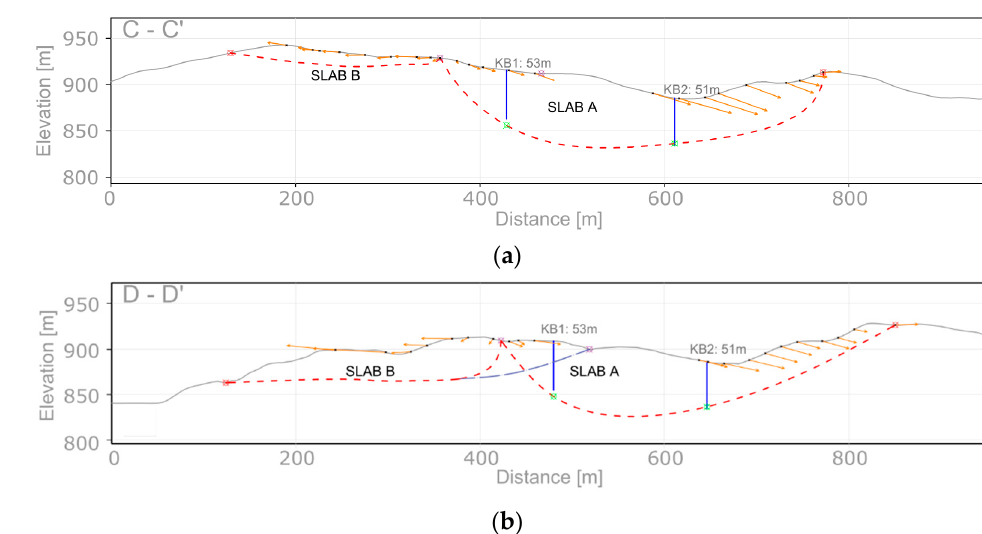
Figure 13. VIM results for the C-C’ ( a ) and D-D’ ( b ) transverse sections, with landslide boundaries (red dots), depth from sections A-A’ and B-B’ (green dots), intersection zone (purple dots), and MSBAS data (orange